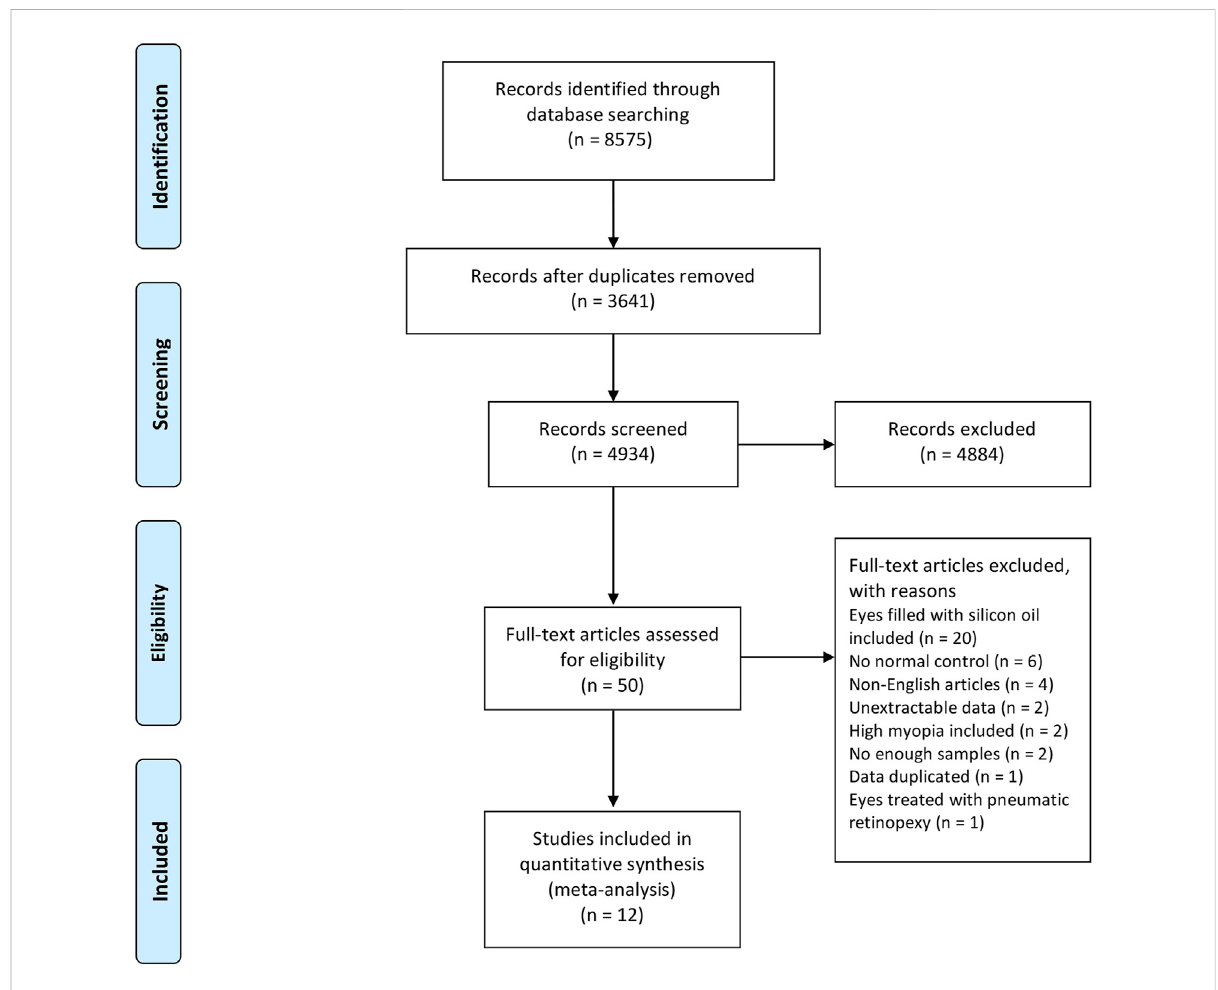
FIGURE 1 Flow chart of studies